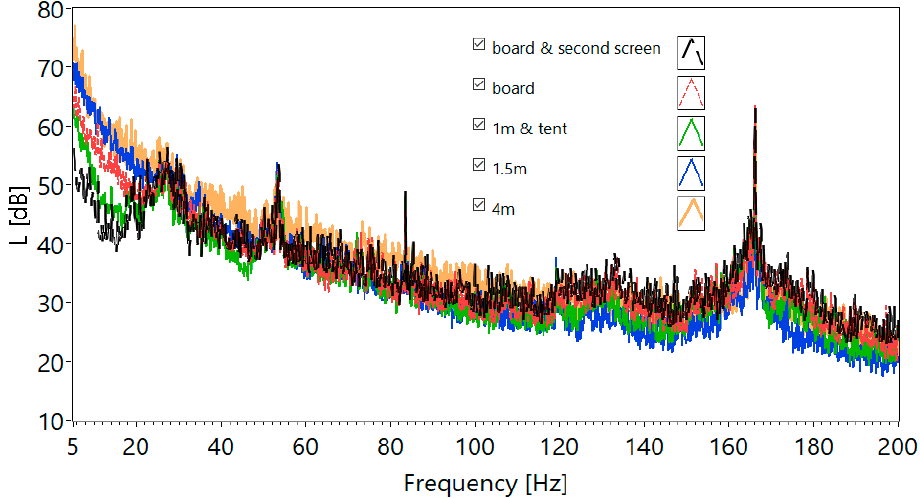
Figure 12. Ventilation shaft noise. FFT spectrum, average wind speed–6.5 m/s.